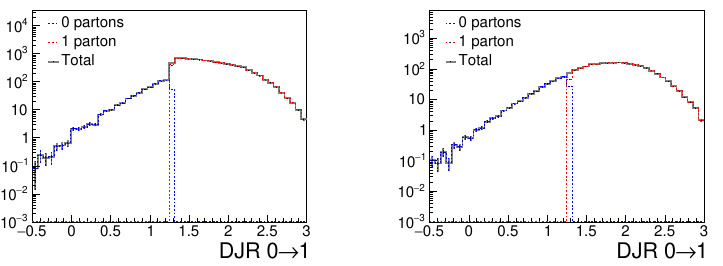
Figure 7 . DJR plots for t¯th with the g - g - t - t - h vertex missing (left) and with the vertex included (right). In both plots, the value of c is set to 2, and all other Wilson coefficients are set to 0. The t G x axis and the lines in the plots are the same as described in figure